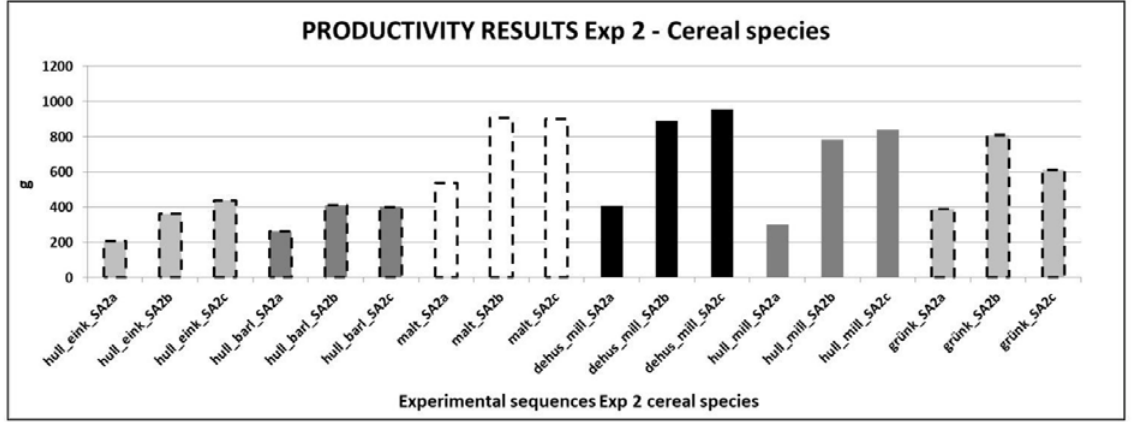
Figure 7. Results of Experiment 2 – cereal ingredients: hulled einkorn ( T. monococcum ), hulled barley ( H. vulgare ), malt (toasted hulled H. vulgare ), dehusked millet ( P. miliaceum ), hulled millet ( P. miliaceum ), Grünkern (unripe and smoked T. spelta ). Note: All sequences performed with SA2 tool type (sandstone tool type 2). Times in all experimental sequences are stable: a= 60 min; b=120 min; c =120 min